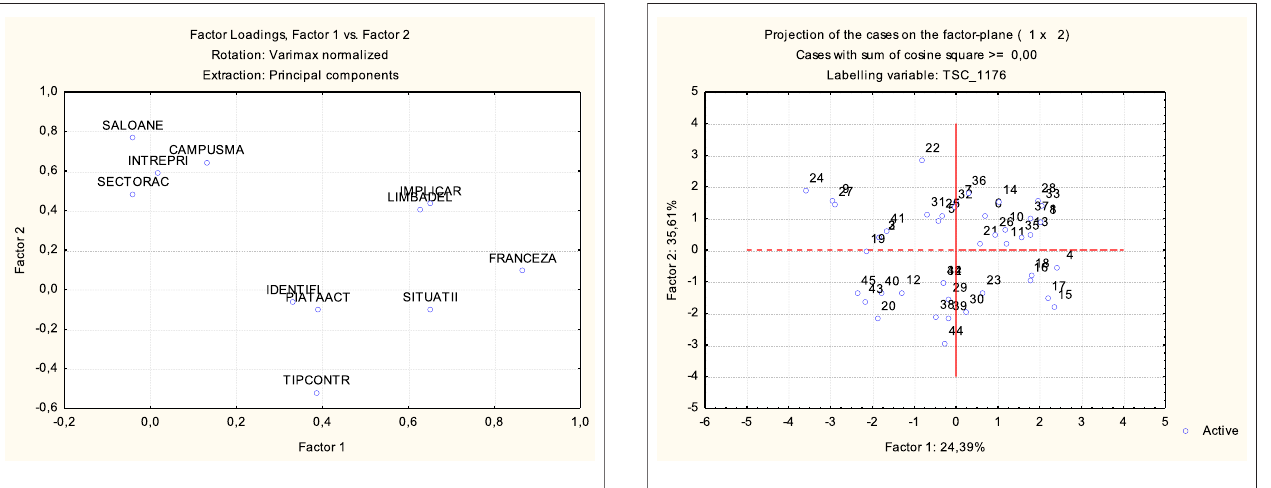
FIGURE 1 | Result of principal component analysis.